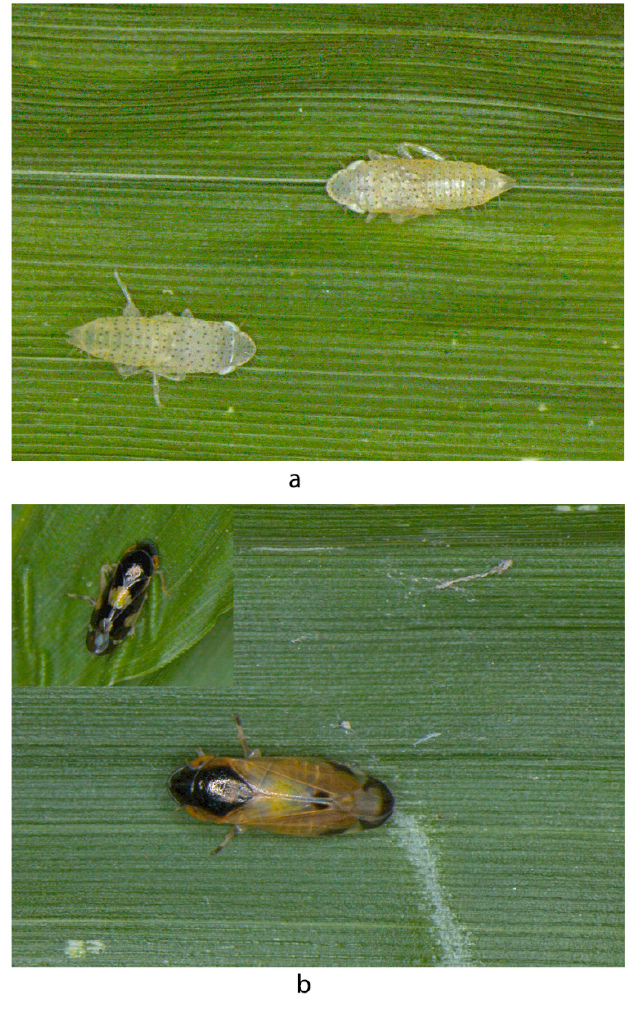
Figure 5. Nymphs and adult Mukaria splendida Distant. ( a )—nymph; ( b